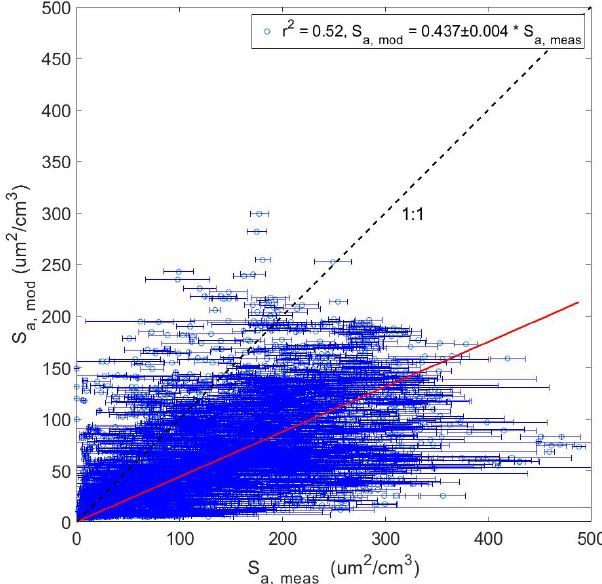
Figure 6. Comparison of S a , mod and S a , meas over the full DISCOVER-AQ campaign with measurement data averaged to the corresponding model latitude, longitude, altitude, and time point.